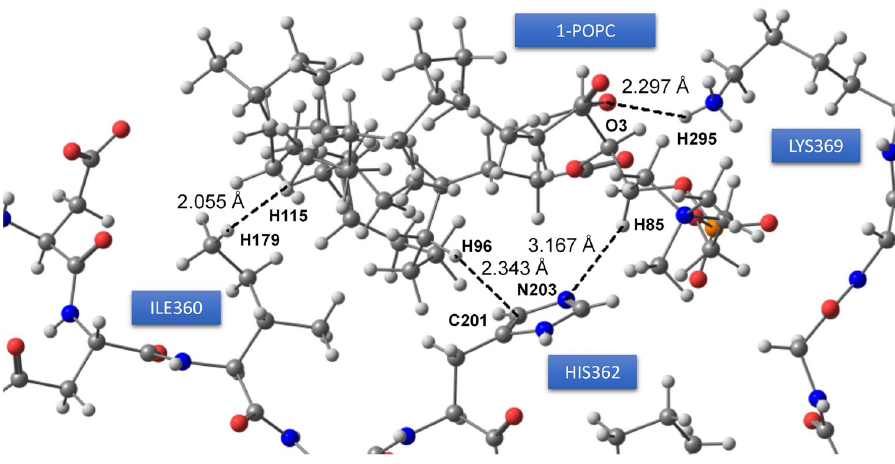
Fig 5. Intermolecular interactions between 1-POPC and PHF-Tau based on NBO analysis. Interatomic distance is shown in angstrom.